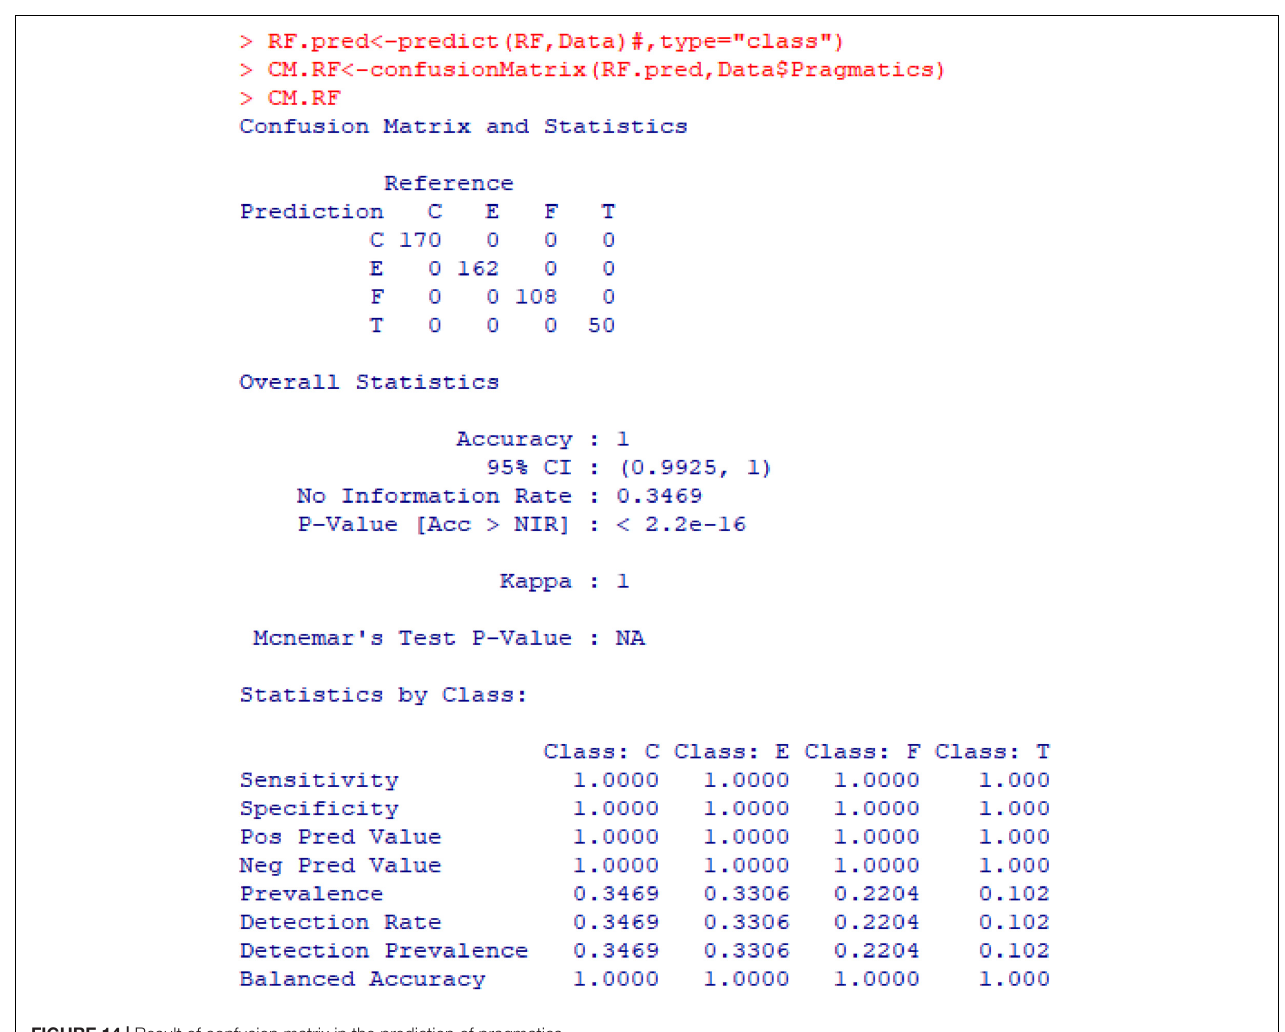
FIGURE 14 | Result of confusion matrix in the prediction of pragmatics.